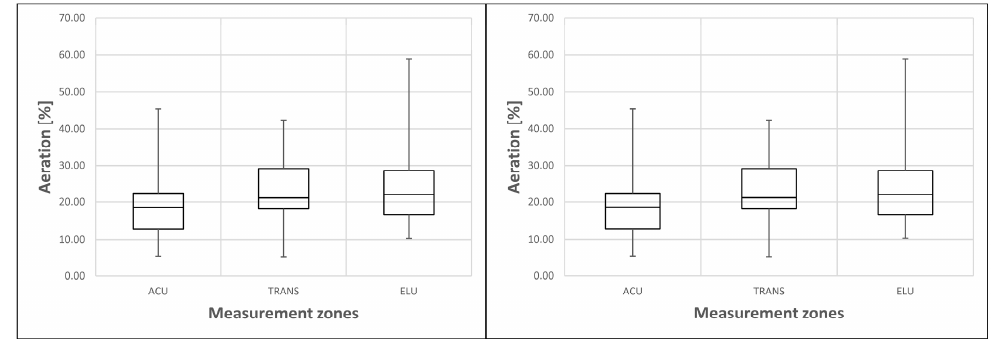
Figure 6. Porosity at the depths of 10 ( left ) and 30 cm ( right ) in the soil profile.